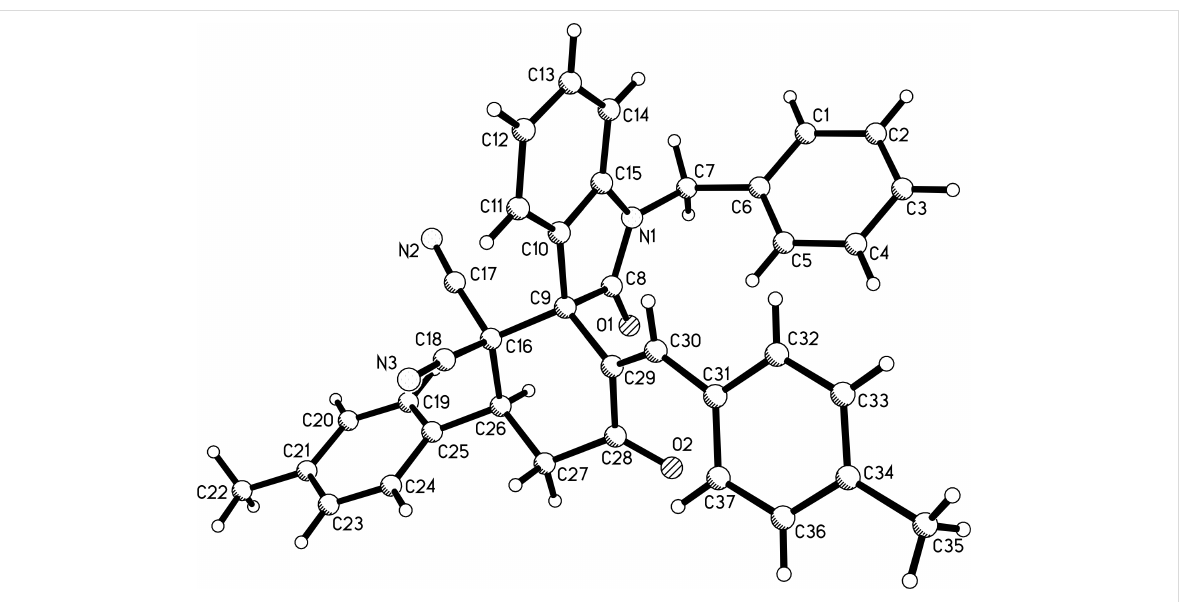
Figure 2: Single crystal structure of compound 3s